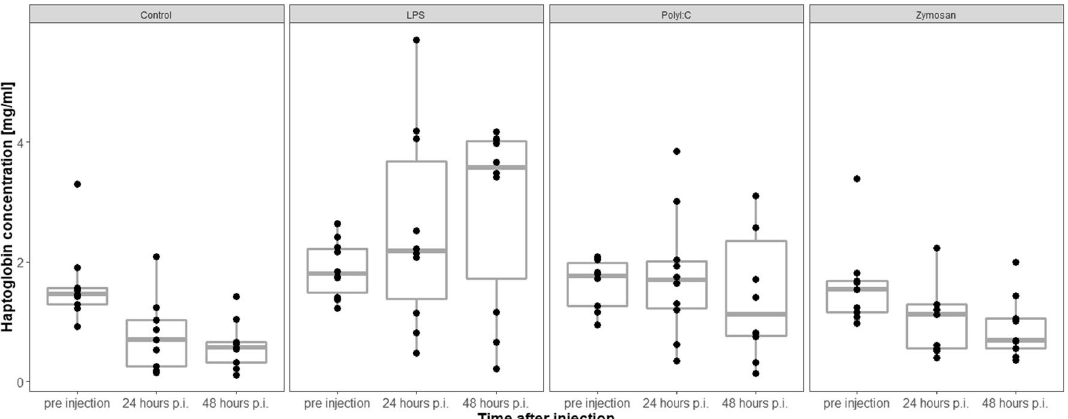
Figure 4. Haptoglobin levels (mg/ml) significantly increased in animals injected with LPS compared to animals injected with saline solution and zymosan. p.i .= post injection. The figures show medians (bold line), 25–75% percentiles (box), maxima and minima (whiskers) and data points